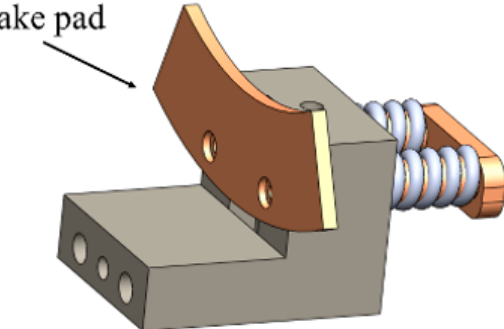
Figure 6. The gadget of the braking system.